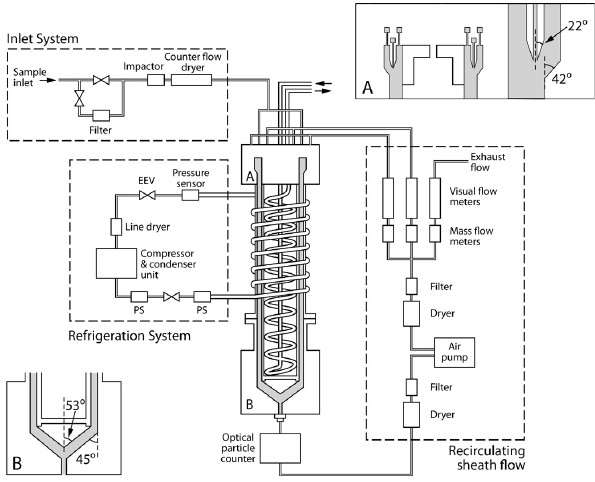
Fig. 1. Schematic of the MINC instrument separated into differ- ent systems: sample inlet, recirculating sheath flow system, refrig- eration system and the chamber. The figure shows the outer wall refrigeration system only. The inner wall system is of the same ar- rangement, where the refrigerant enters/exits the coil via the arrows shown. PS=pressure sensor, EEV=electronic expansion valve, OPC=optical particle counter, see main text for description. A close up of the entrance and exit to the chamber are labelled as A and B